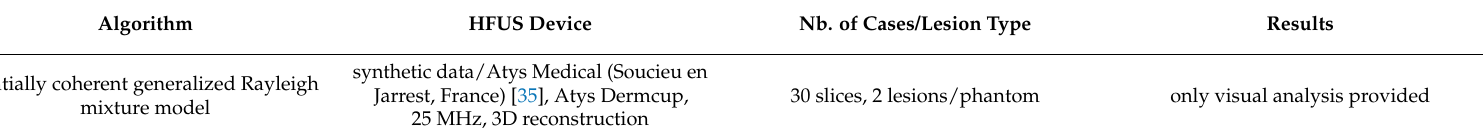
Table 6. Skin tumor segmentation